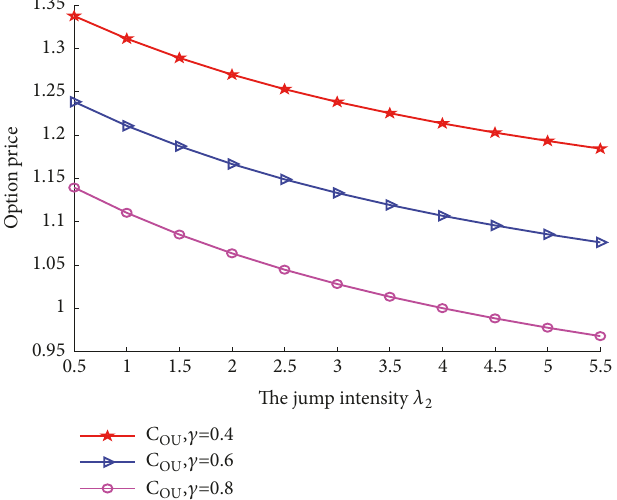
Figure 5: The effect of the jump intensity 𝜆 2 on the vulnerable option